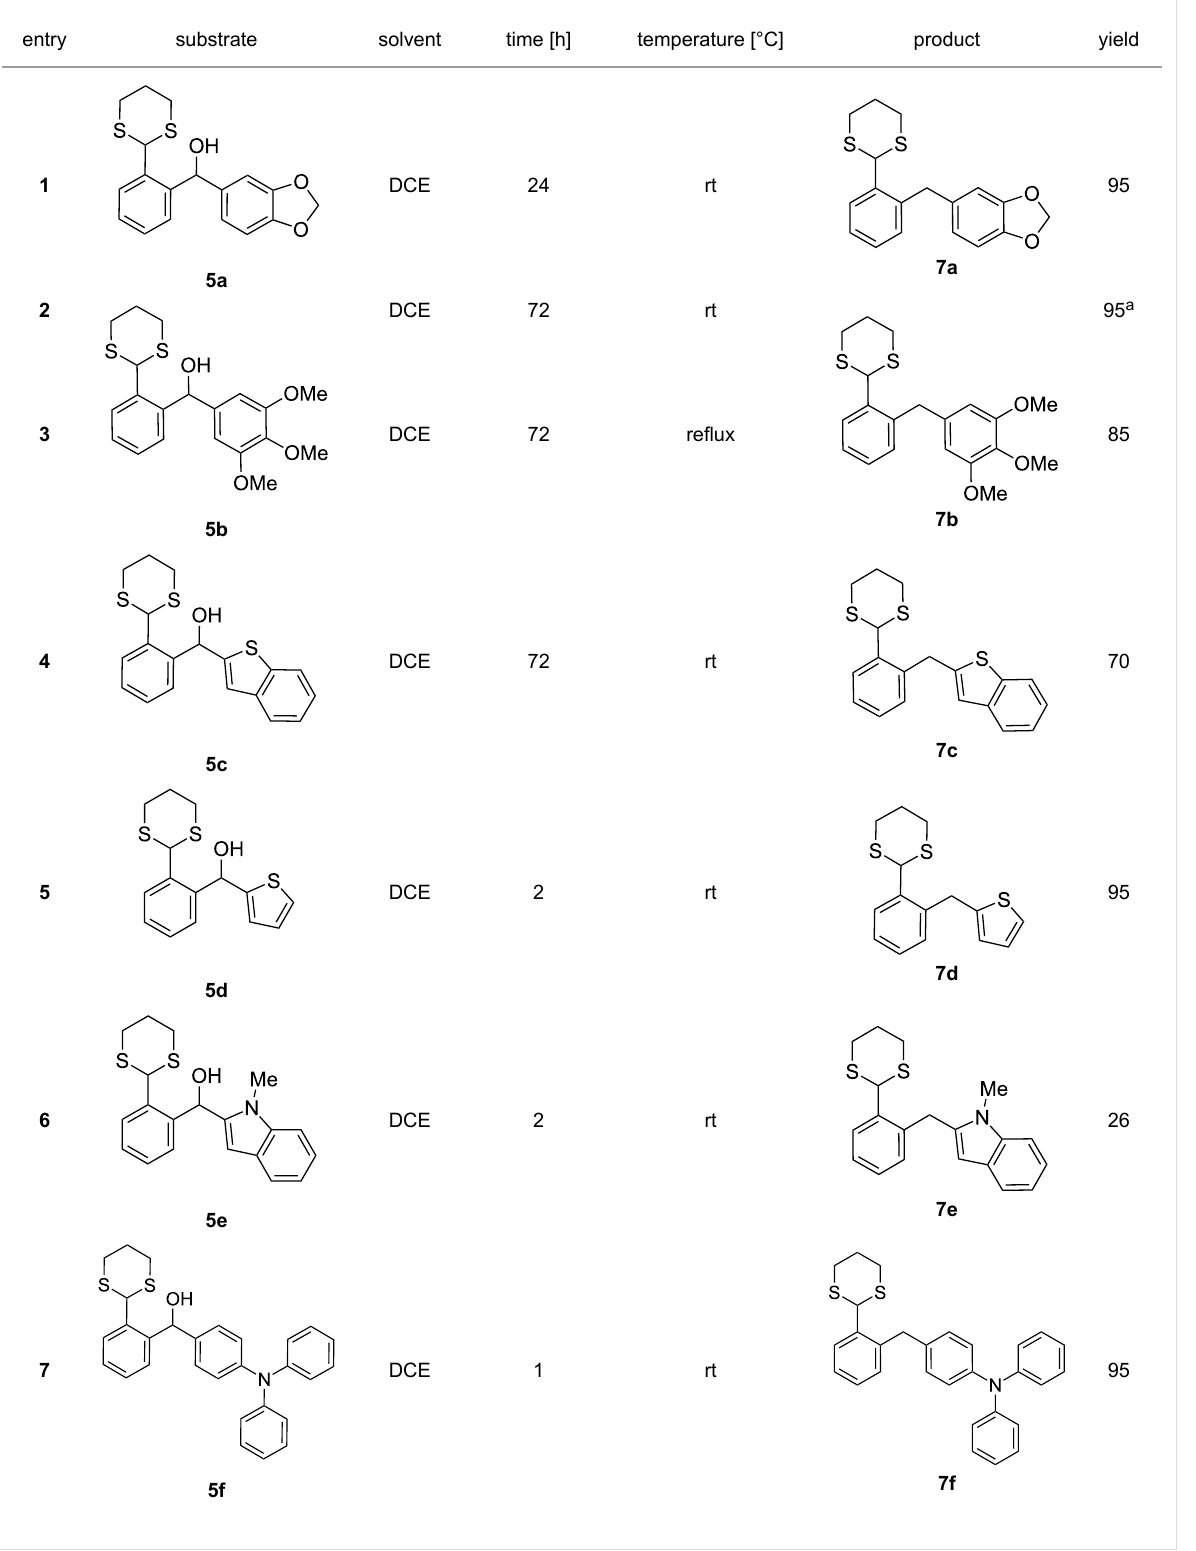
Table 1: A selective reduction of ortho- 1,3-dithianylaryl(aryl)methanols to ortho- 1,3-dithianylaryl(aryl)methanes using the ZnI 2 /Na(CN)BH 3 reducing system.